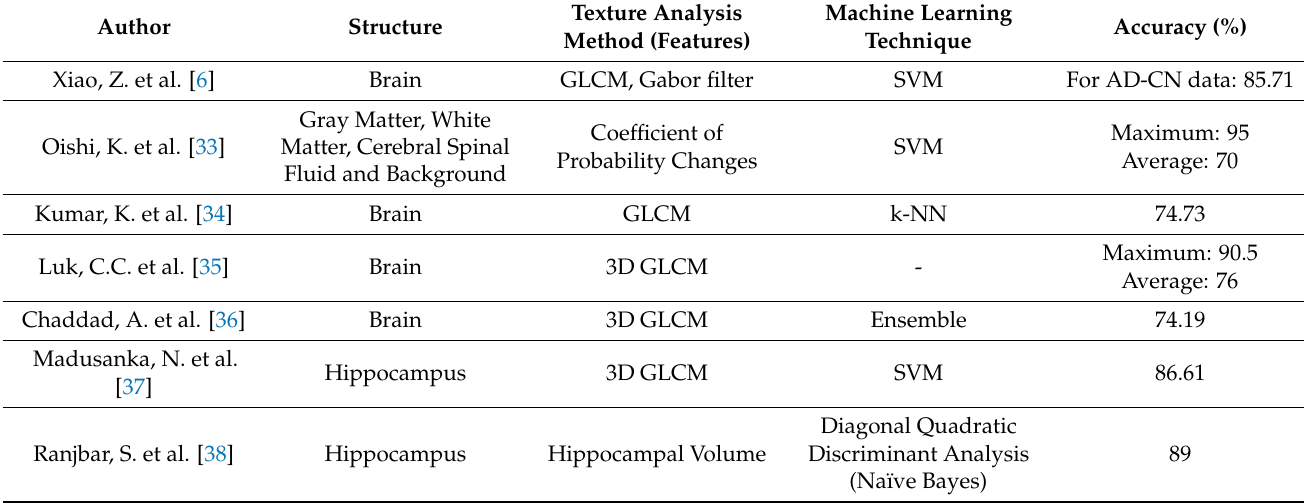
Table 6. Classification accuracy based on texture analysis and machine learning